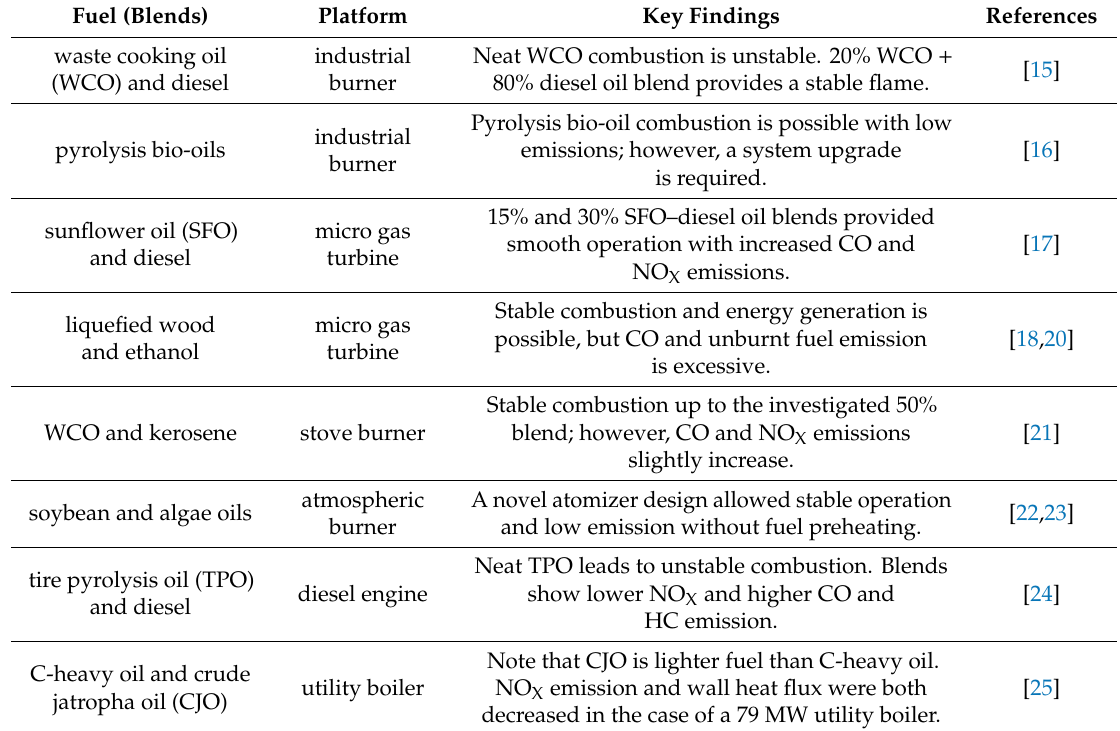
Table 1. Literature survey of heavy renewable fuels (HRF)